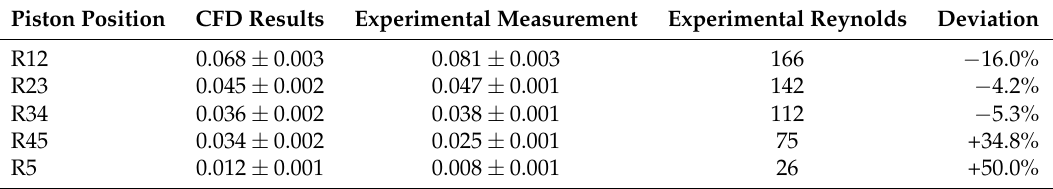
Table 3. Flow coefficients for numerical simulations and experimental measurements for off-centered piston. Piston Position